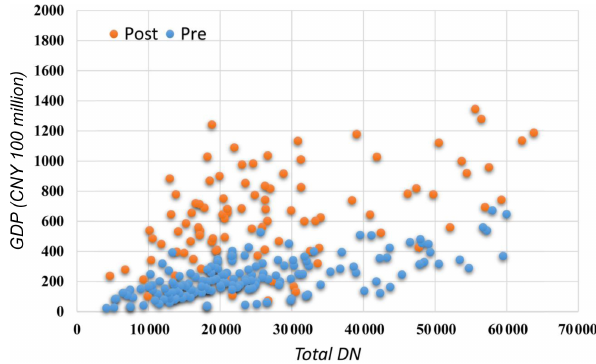
Figure 5. DN–GDP scatter plots of before and after the earthquake in Sichuan (maxima have been